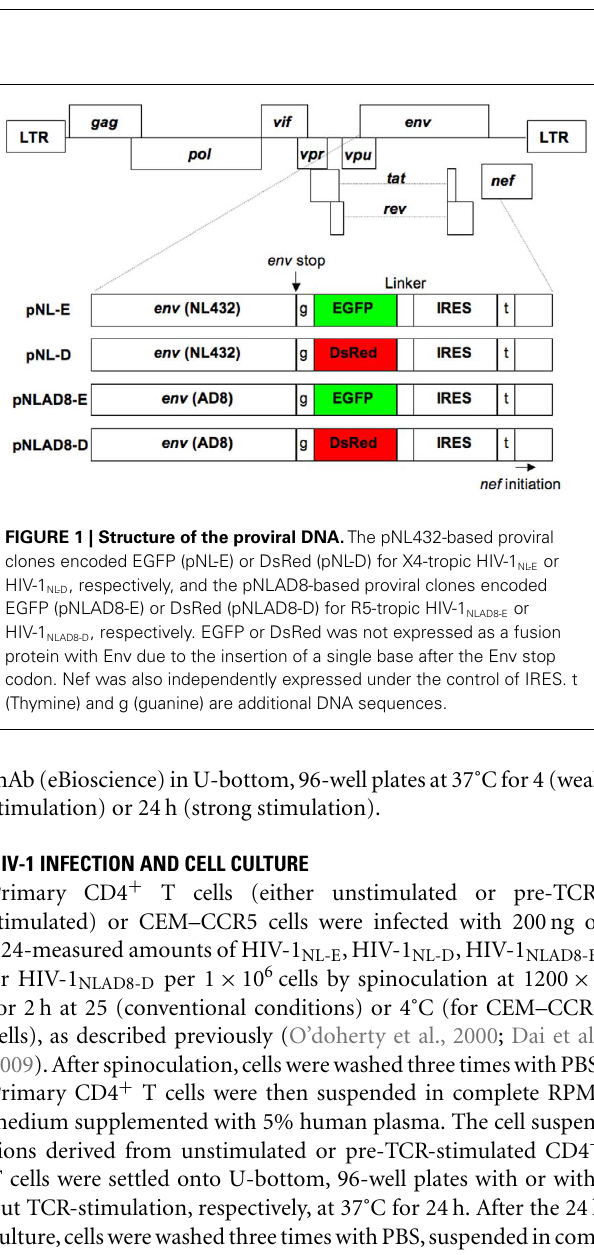
mAb (eBioscience) in U-bottom,96-well plates at 37˚C for 4 (weak stimulation) or 24 h (strong